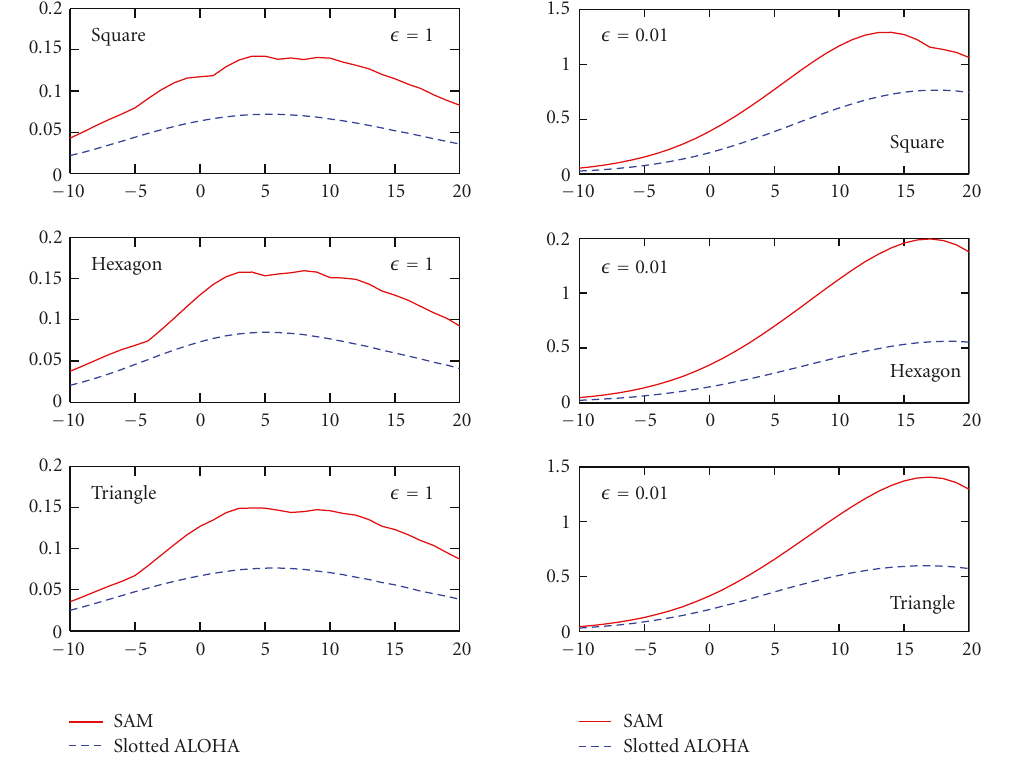
Figure 10: The ( p , q )-optimal α SAM,fading versus η in dB and the p t -optimal α ALOHA,fading versus η in dB for three topologies, n = 4, and SNR 0 = 30dB. The left column of plots is for (cid:2) = 1 (omnidirectional antennas). The right column of plots is for (cid:2) = 0 . 01 (directional